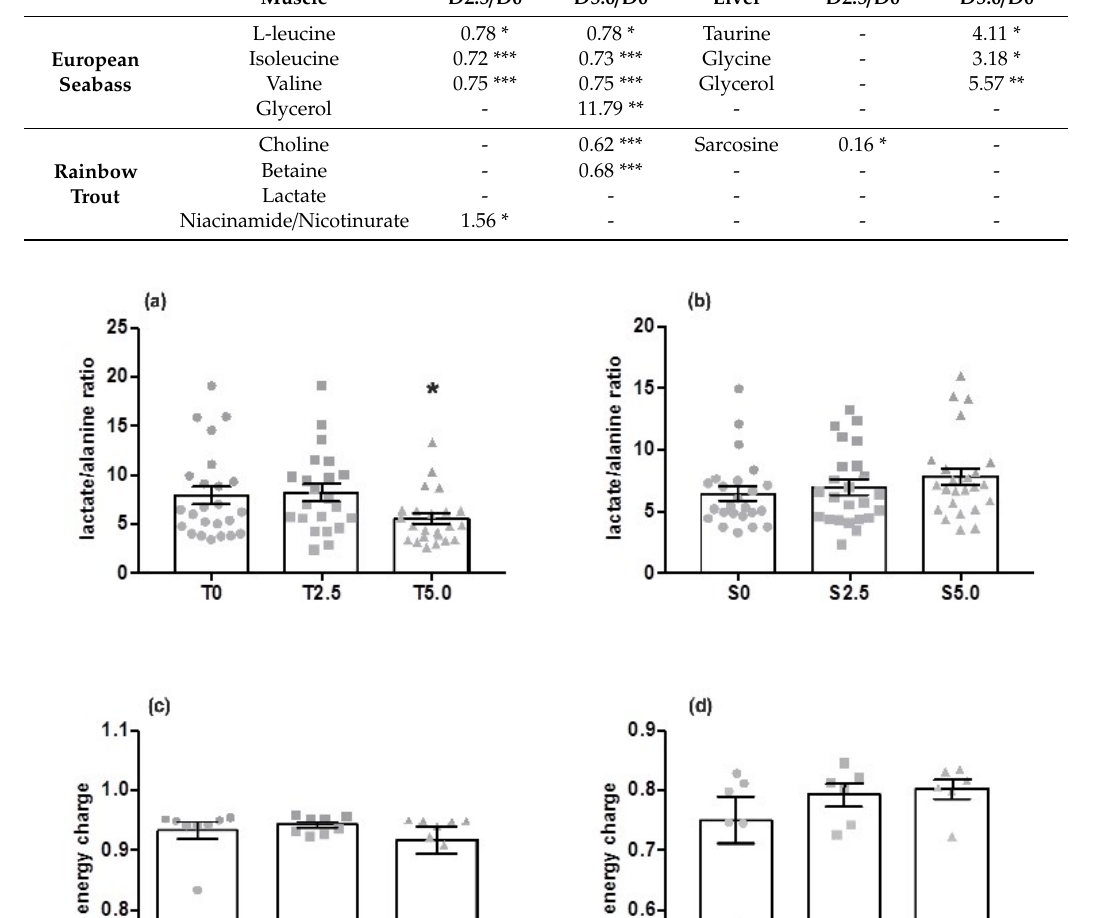
Table 1. Summary of the metabolites with a significant fold-change variation between groups fed with the control diet (D0) and the diets supplemented with 2.5% (D2.5) or 5.0% (D5.0) glycerol. Significance